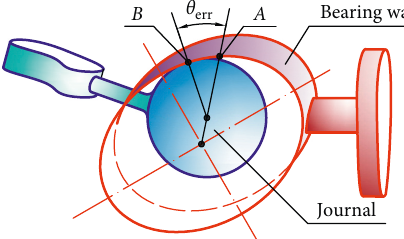
Figure 4: Schematic overview of angle error when the bearing ellipse contacts the journal circle.